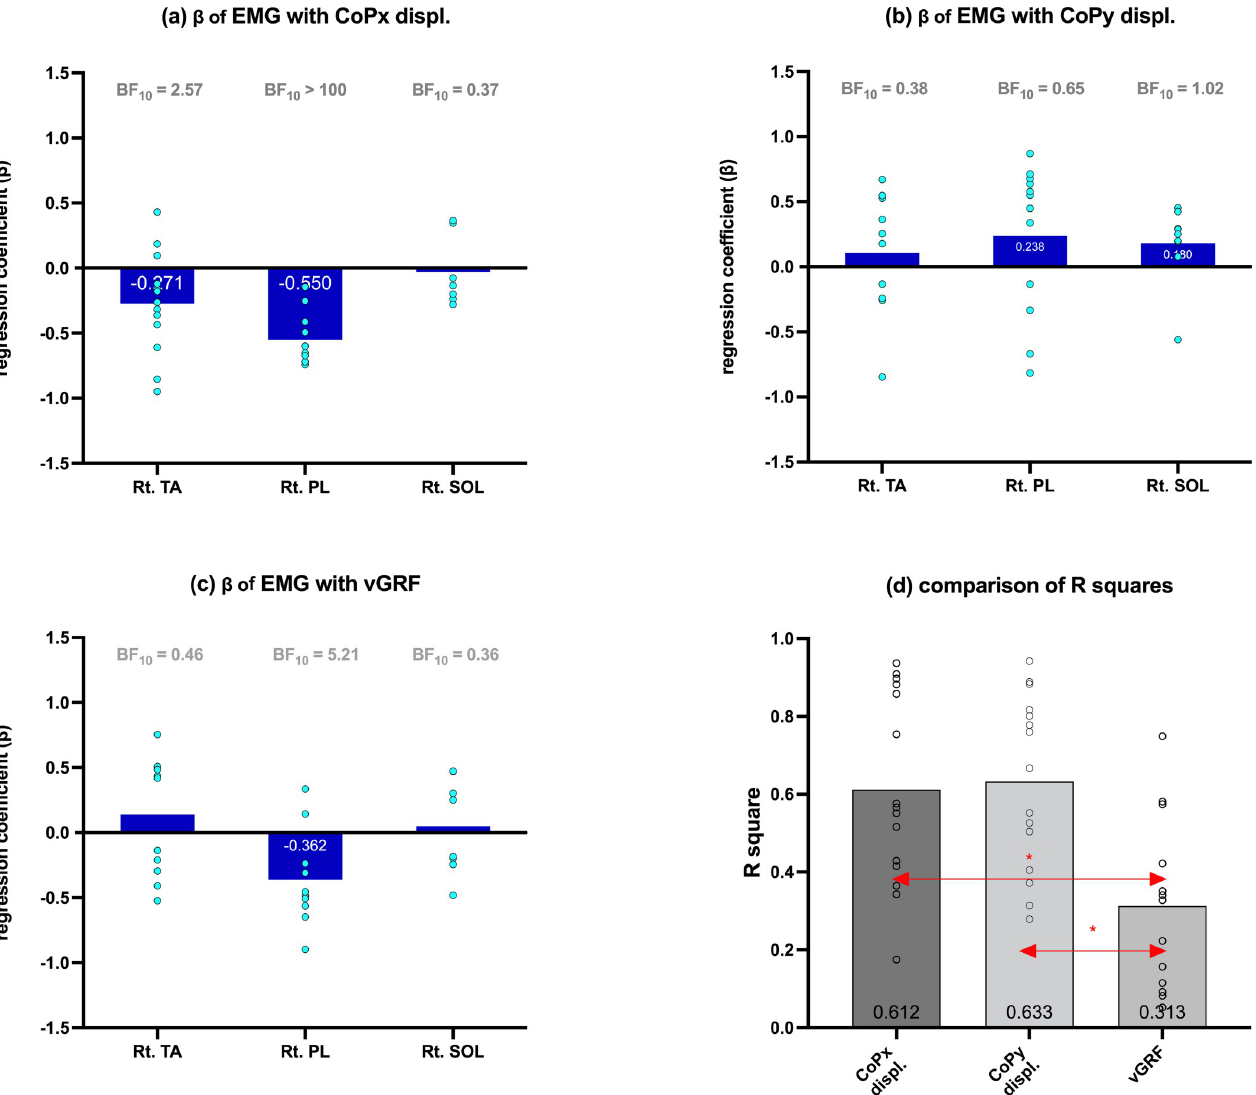
Fig 7. Standardized regression coefficients ( β ) of EMG_Lt.PL, EMG_Lt.TA, and EMG_Lt.SOL with (a) foot CoPx displacement, (b) foot CoPy displacement, and (c) vGRF during the right loading phase. The box height represents the mean value, and the circles represent individual data points. The Bayes factors (BF 10 ) indicate the evidence level that the regression coefficients are different from zero. (d) R 2 of the three dependent variables Red arrow with ( � ) shows the significantly different pair on ANOVA post-hoc comparison (p < 0.05 Tukey). Numbers in the box represent the mean values of the variable.